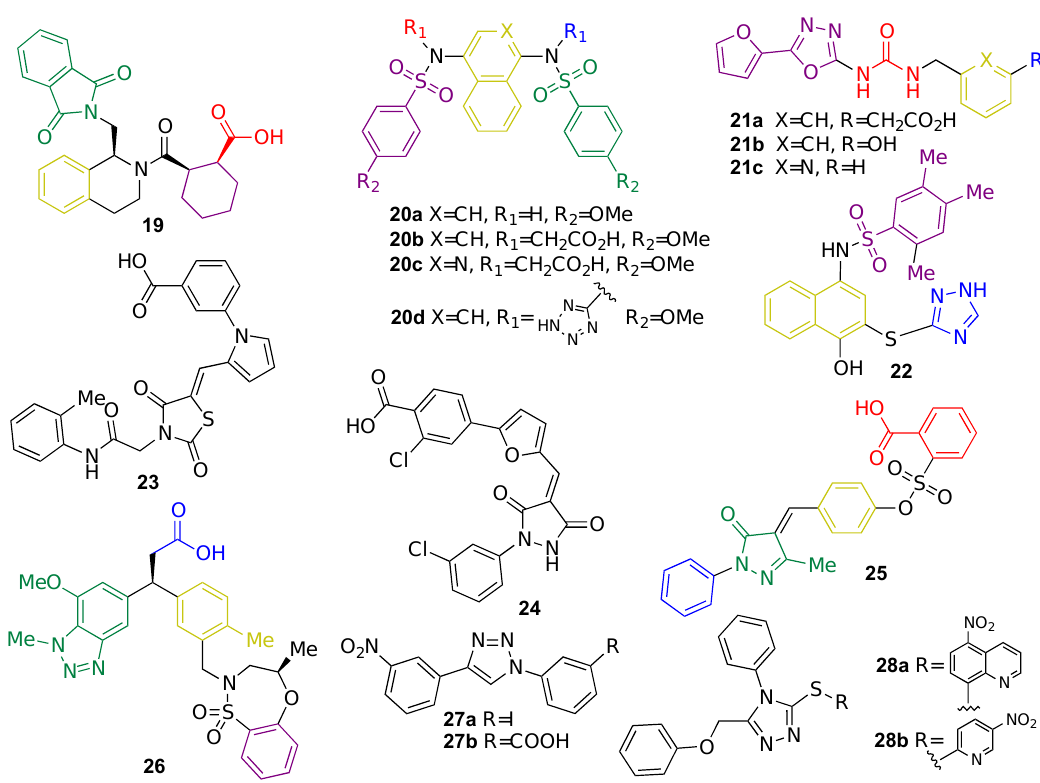
Figure 12. Chemical structures of KEAP1 protein–protein interaction inhibitors 19 – 28 . Compounds 19 , 20 , 21 , 22 , 25 and 28 have been crystalized with KEAP1 and/or their interaction pattern has been proposed by using molecular modeling and molecular dynamics. Their interaction pattern with KEAP1 has been coded by giving different colors to the motif of each molecule that interacts with each pocket as follows: interaction at P1: blue; interaction at P2: red; interaction at P3: yellow; interaction at P4: green; and interaction at P5: purple.